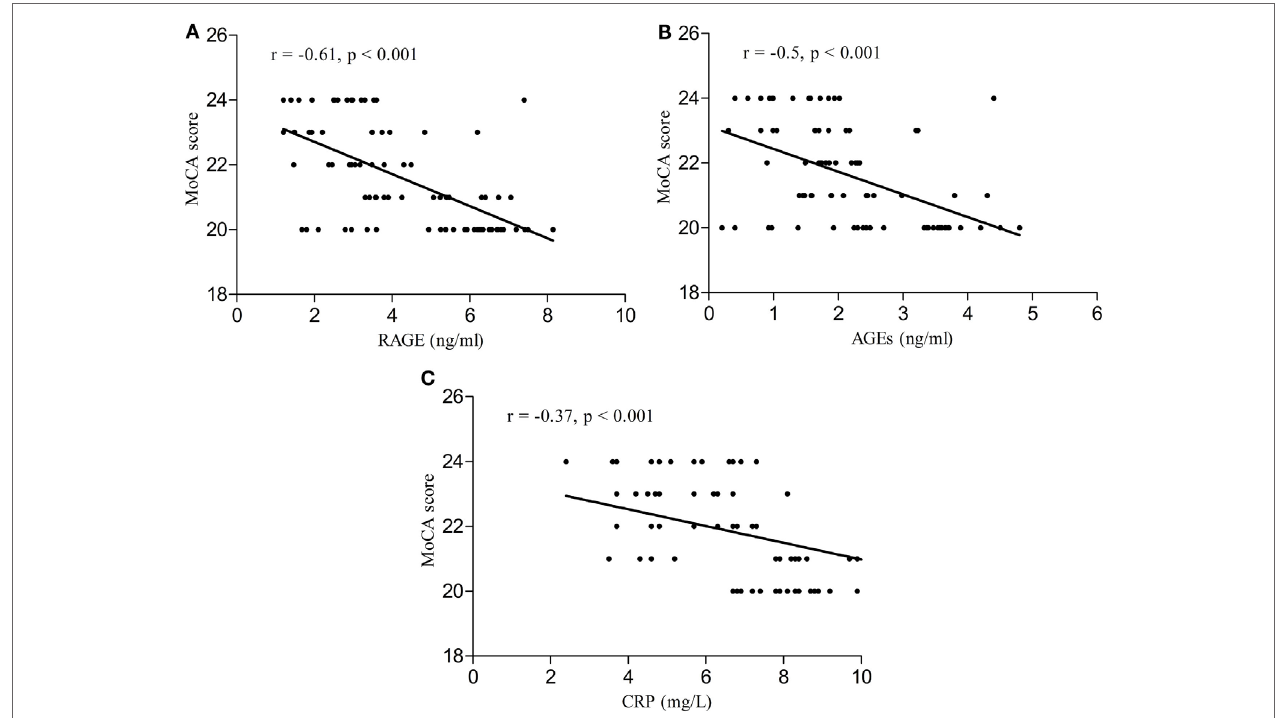
FigUre 3 | (a) Correlation of MoCA score with RAGE in group of diabetic elderly patients with MCI. (B) Correlation of MoCA score with AGEs in group of diabetic elderly patients with MCI. (c) Correlation of MoCA score with CRP in group of diabetic elderly patients with MCI.